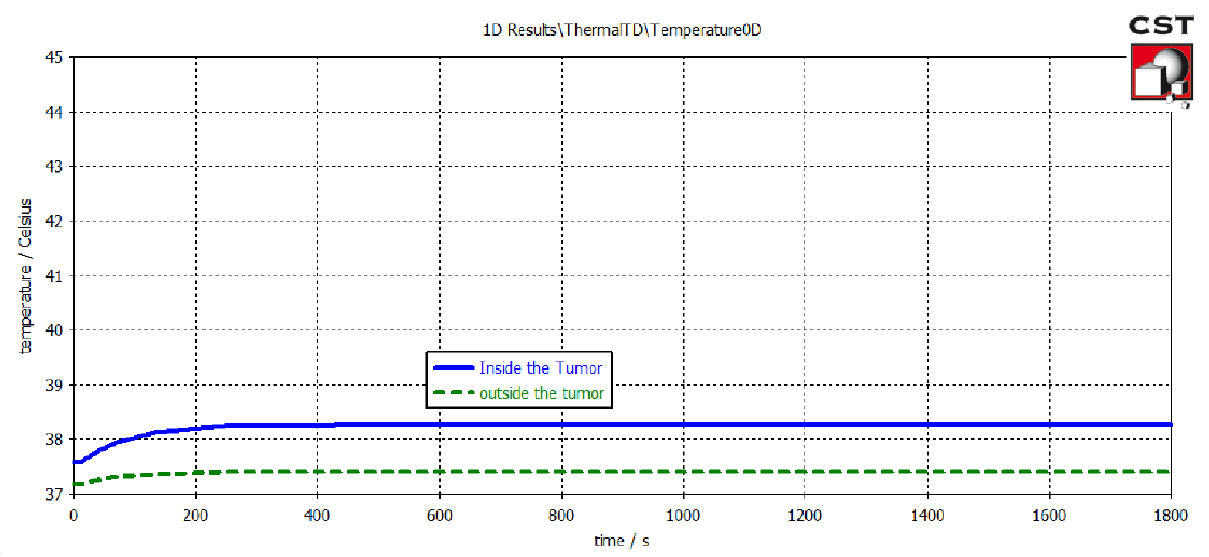
Figure 11: Temperature distribution during hyperthermia without